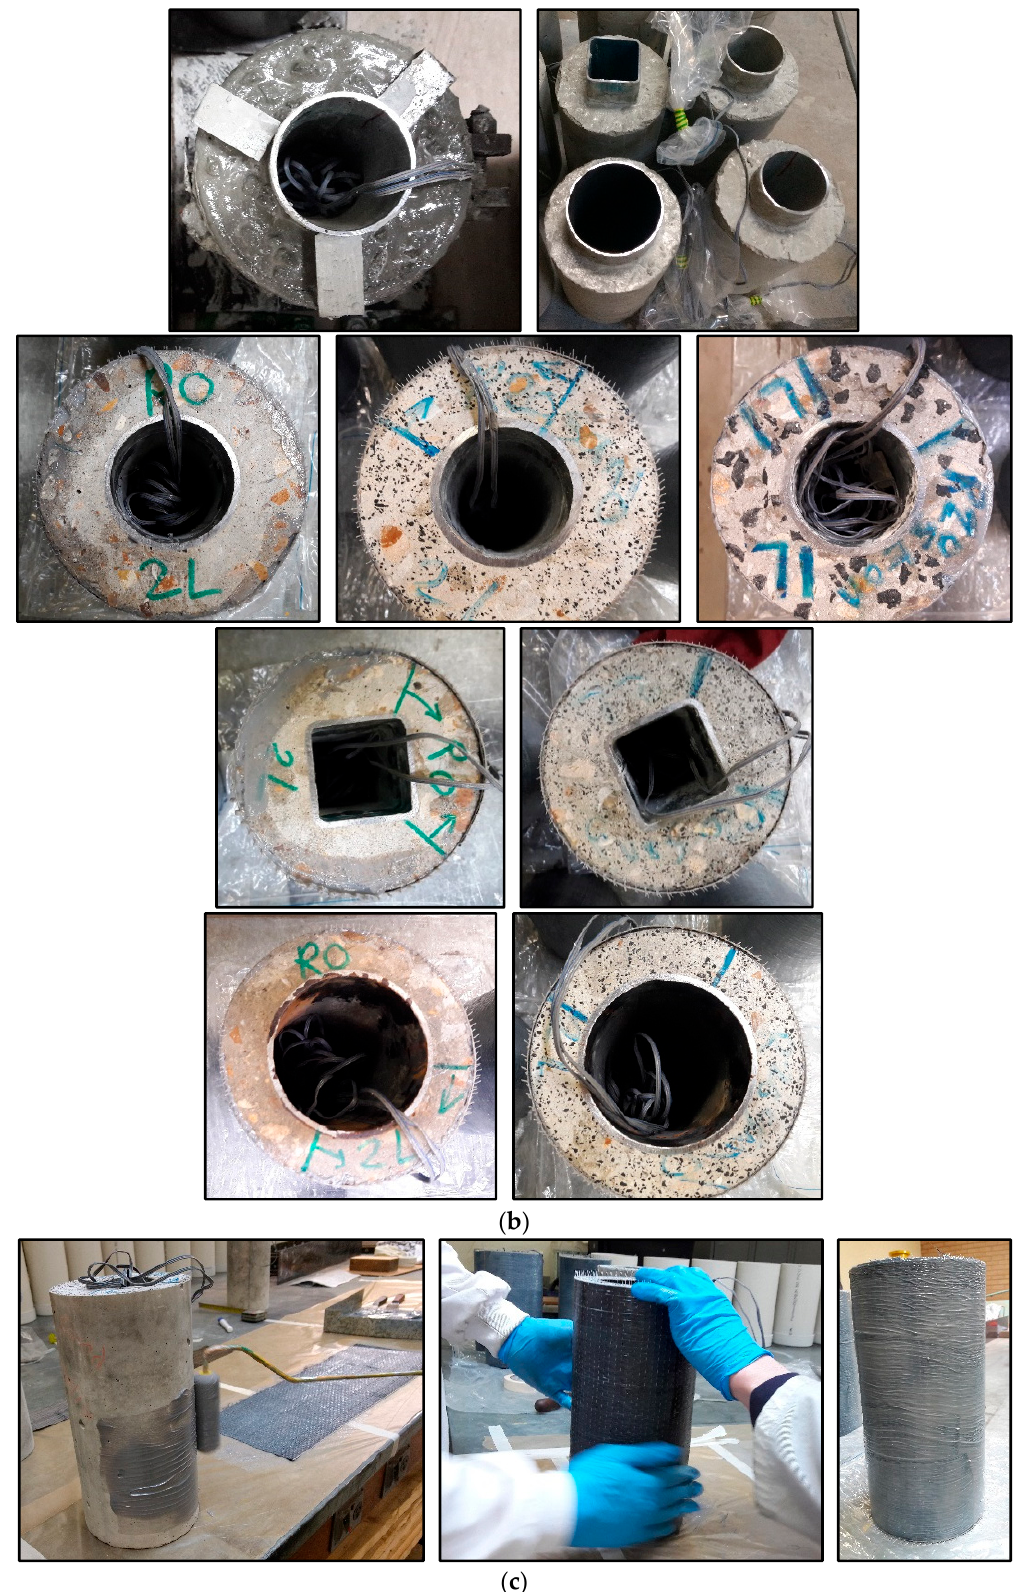
Figure 3. Specimen preparation: ( a ) Inner steel tube and moulds, ( b ) concrete casting and end grinding, and ( c ) FRP-wrapping.